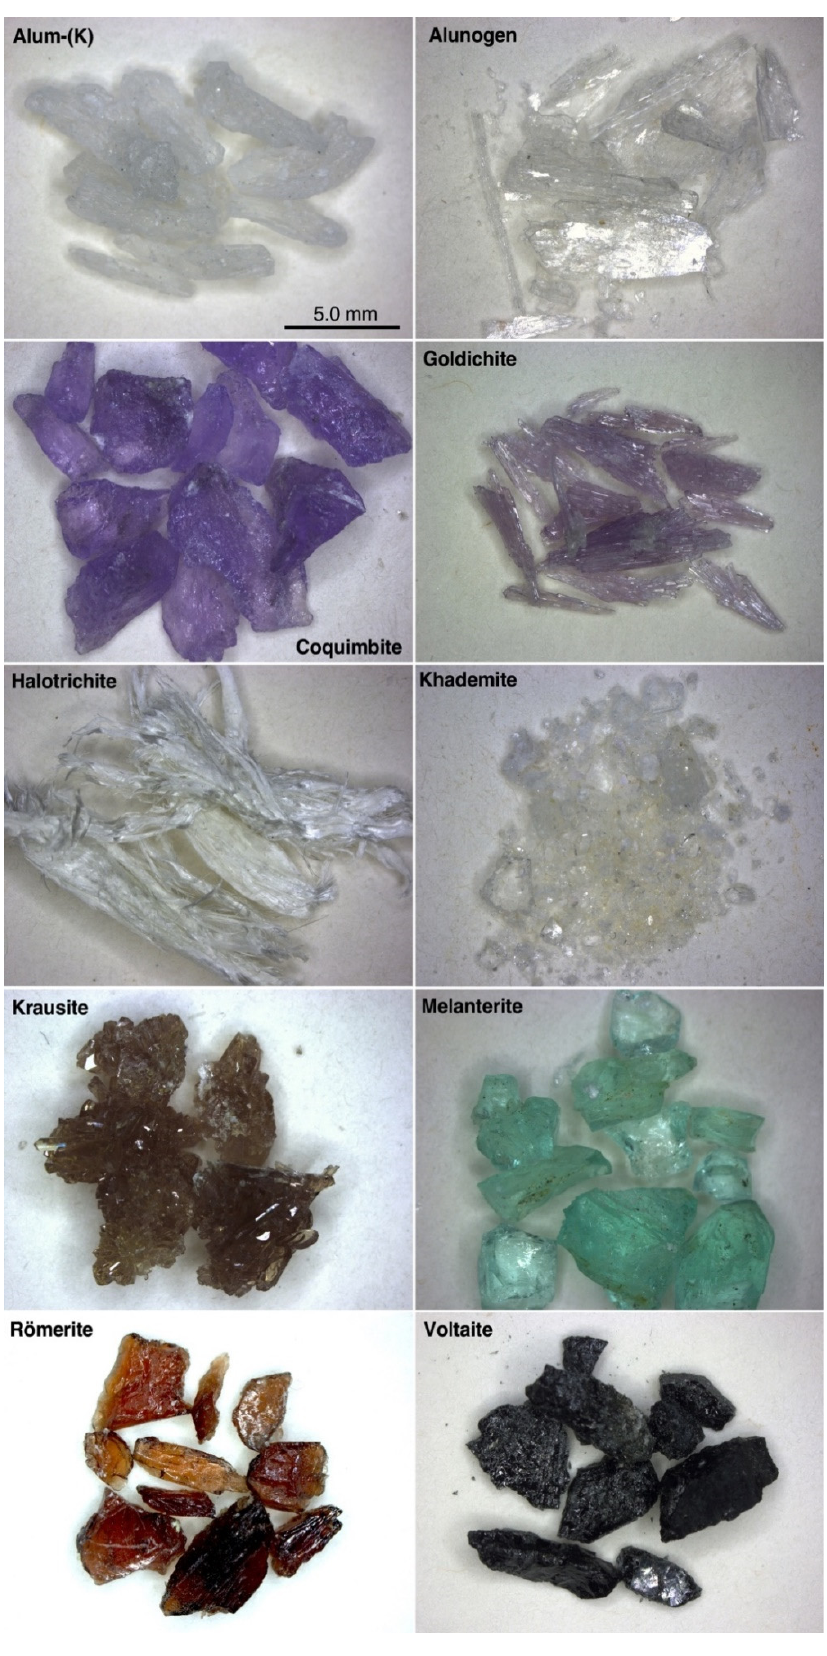
Figure 3. The sulfates used for this study. Purified aliquots of these samples were selected for the geochemical analyses. The pictures were all taken at the same magnification.